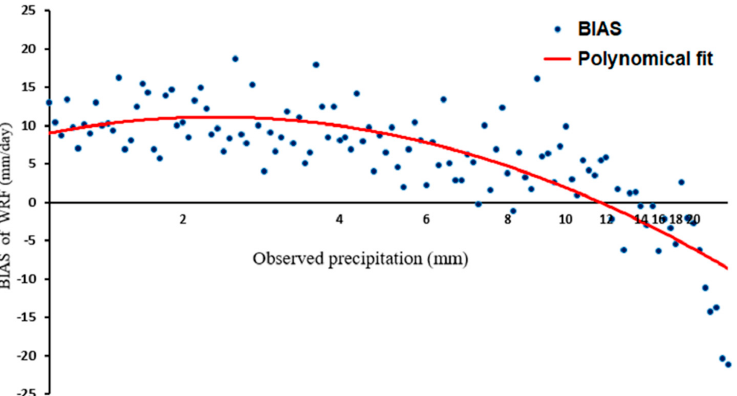
Figure 13. Bias curve of the Weather Research and Forecasting (WRF) model relative to observed precipitation. The red line shows its second-order polynomial fit curve.